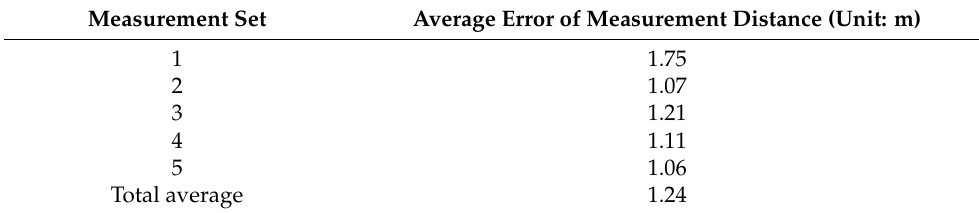
Table 2. Average error between beacon measurement data and PDR measurement data.